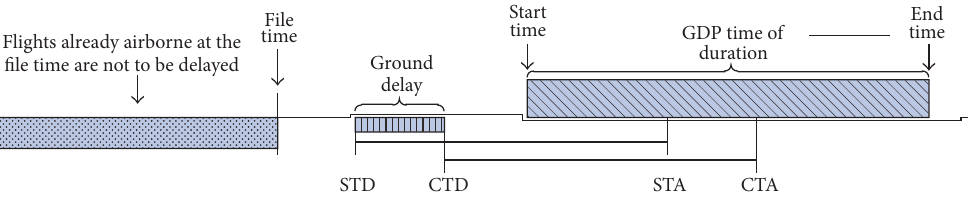
Figure 1: Illustration of key GDP time parameters.